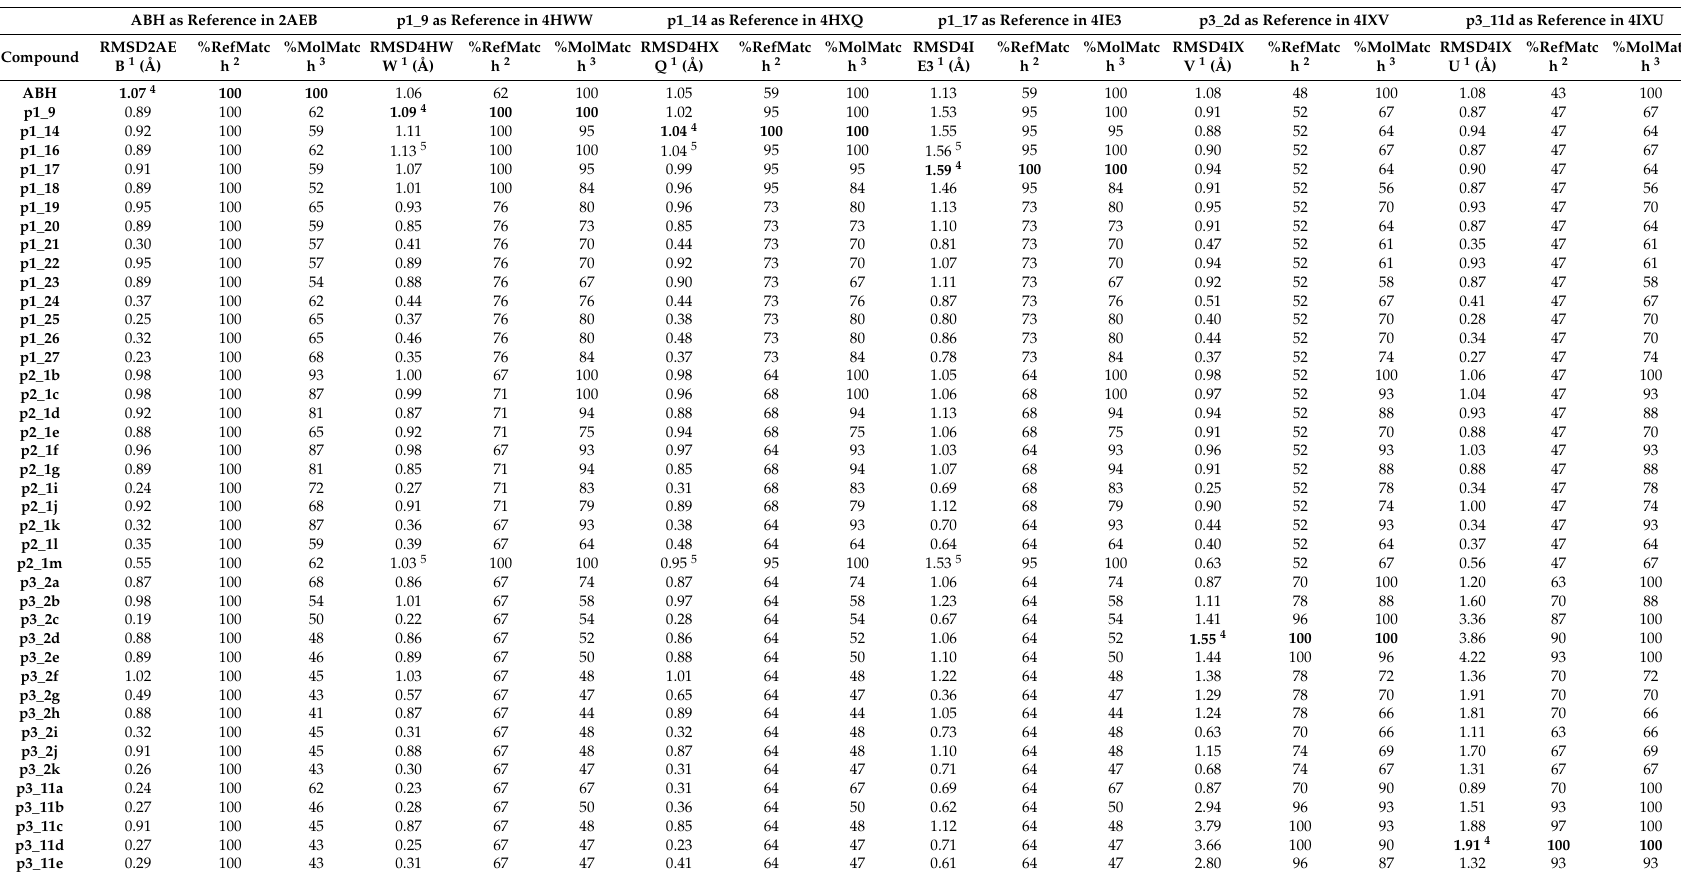
Table 4. RMSD#PDB values of the obtained docking pose common fragments for the studied compounds with respect to available co-crystallized hARGI inhibitors (identified by their #PDB codes) as references. ABH as Reference in 2AEB p1_9 as Reference in 4HWW p1_14 as Reference in 4HXQ p1_17 as Reference in 4IE3 p3_2d as Reference in 4IXV p3_11d as Reference in 4IXU Compound RMSD2AE B 1 (Å)